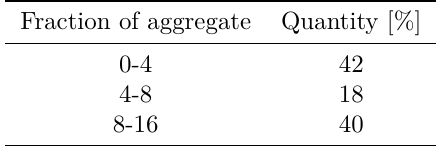
Table 4. Aggregate composition.